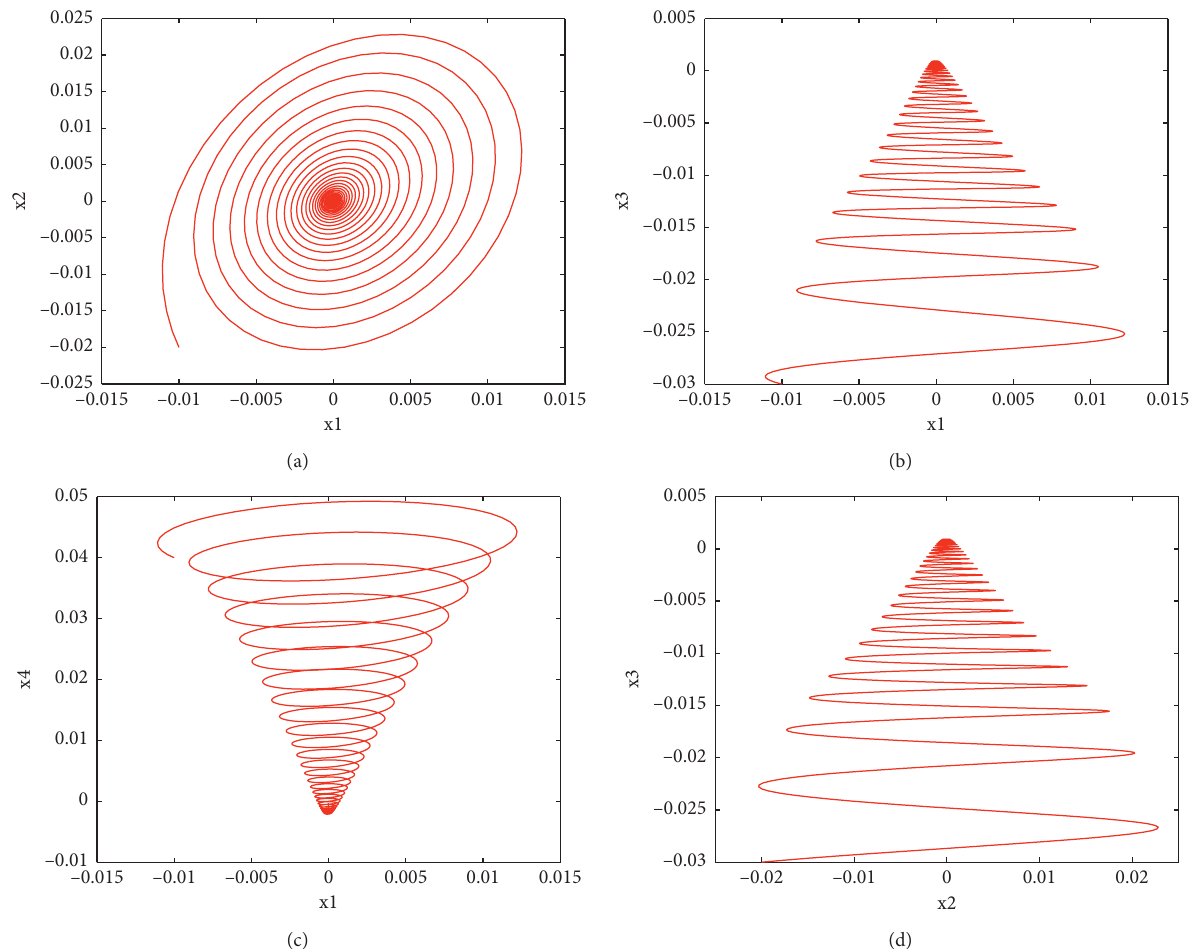
Figure 8: Attractor of the fractional-order novel hyperchaotic system with order α � 1.14 ( a � 10, b � 40, c � 2.5, and d �